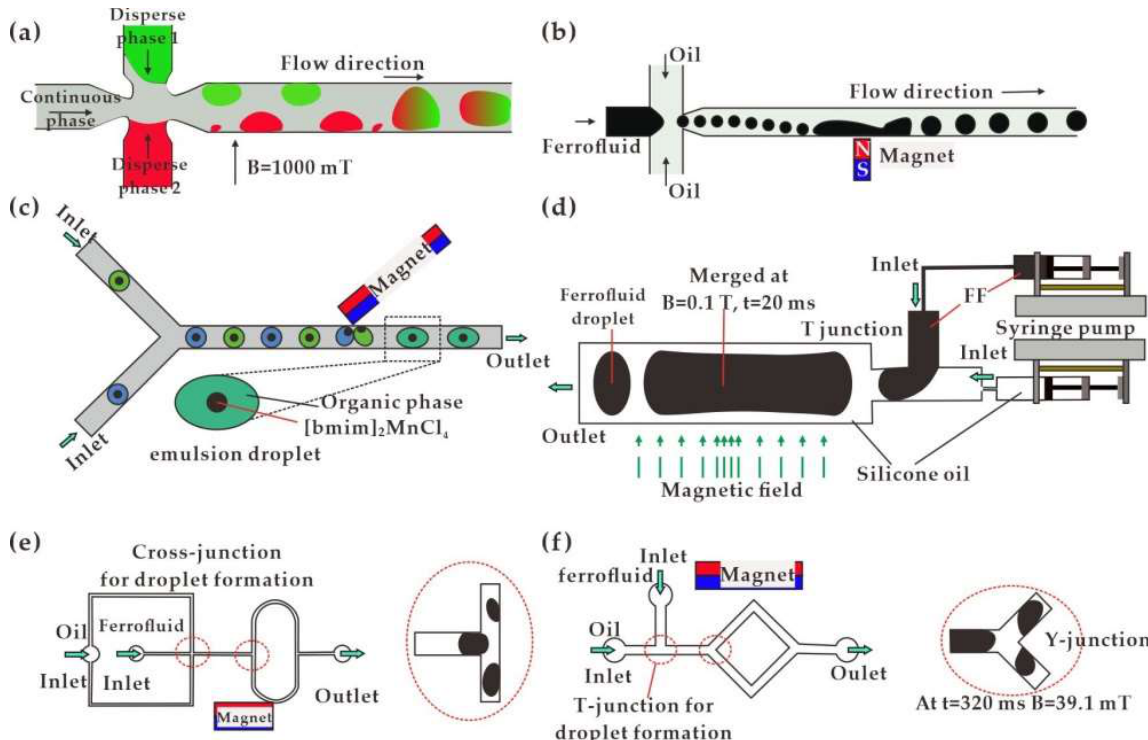
Figure 5. Droplet coalescence and splitting in a magnetic field: ( a ) Uniform magnetic field induced droplet merging in a cross-shaped channel [22]; ( b ) Permanent magnet induced droplet merging in a cross-shaped channel [23]; ( c ) Permanent magnet induced droplet merging in a Y-shaped channel [24]; ( d ) Droplet merging in coupling uniform and non-uniform magnetic fields [25]; ( e ) Droplet splitting in T-shaped channel [26]; ( f ) Droplet splitting in Y-shaped channel [27].